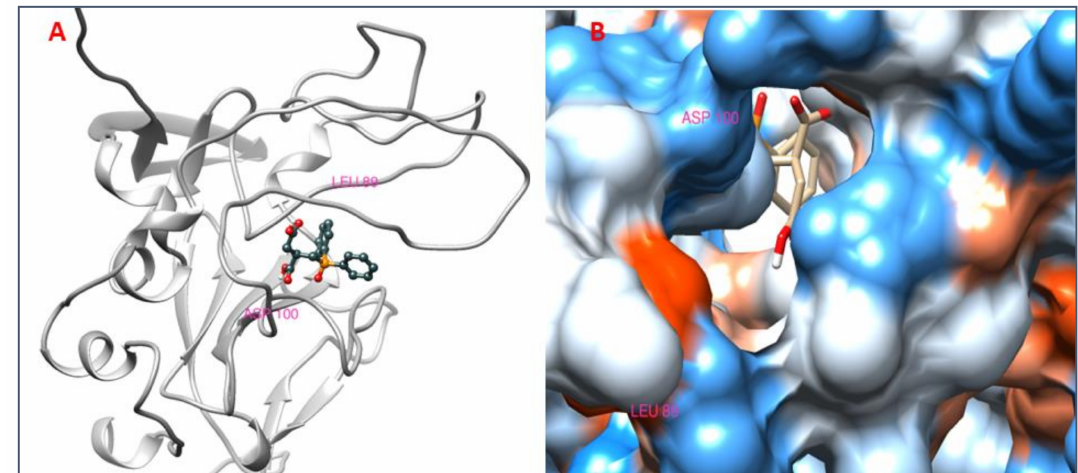
Figure 13. ( A ) 3D interaction of [(2R,3R)-8-[(2R,3R,4R)-5,7-dihydroxy-3-(3,4,5- trihydroxybenzoyl)oxy-2-(3,4,5-trihydroxyphenyl)- 3,4-dihydro-2H-chromen-4-yl]-5,7-dihydroxy-2-(3,4,5-trihydroxyphenyl)-3,4-dihydro-2H-chromen-3-yl] 3,4,5-trihydroxybenzoate and HCV E2 protein having binding affinity − 11.8. ( B ) Surface representation of interaction.